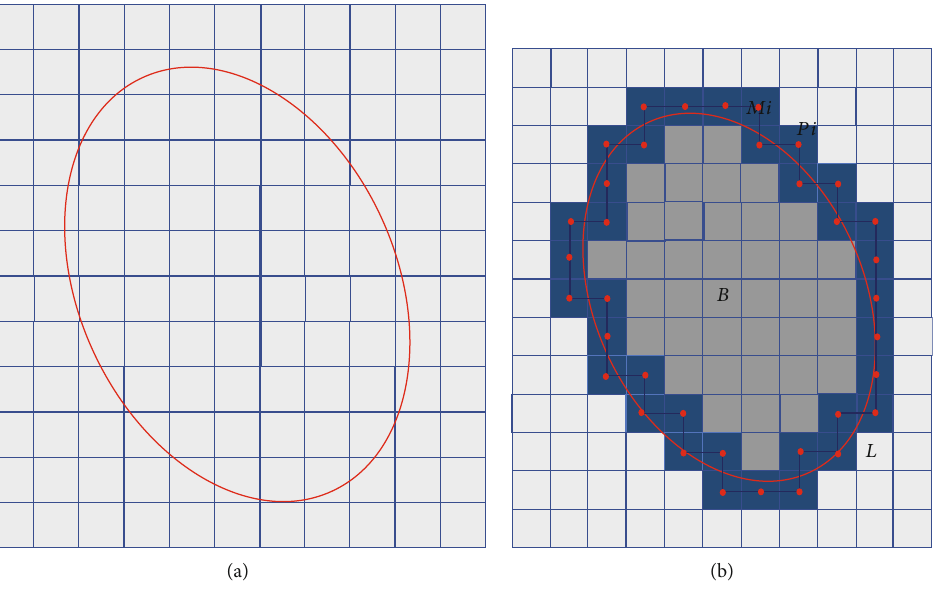
Figure 1: Comparison of the gridding treatment for arc-shaped obstacles. (a) Before treatment. (b) After